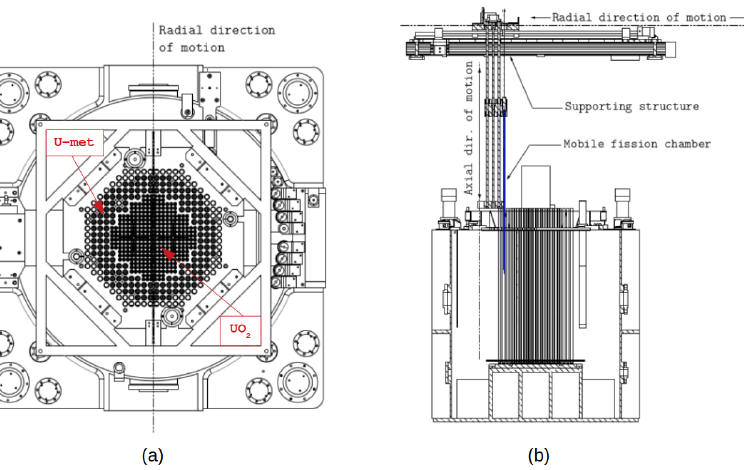
Figure 1. Schematics of CROCUS: ( a ) Top-view of the loading pattern with the inner UO 2 and outer U-metal lattices and ( b ) axial section of the reactor vessel and its internal structures. The Translateur Radial AXial (TRAX) system for in core fission chambers measurements [14] is displayed on both